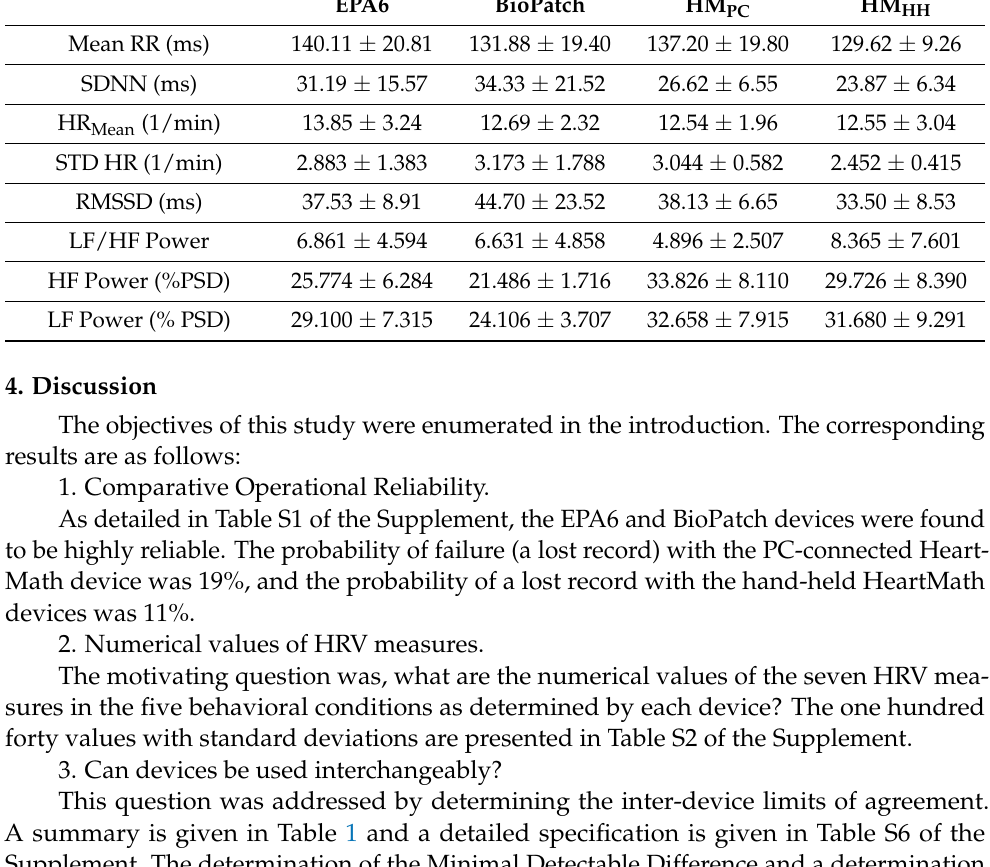
Table 2. Summary: Minimal detectable differences averaged across behavioral conditions (Mean ± Standard Deviation).